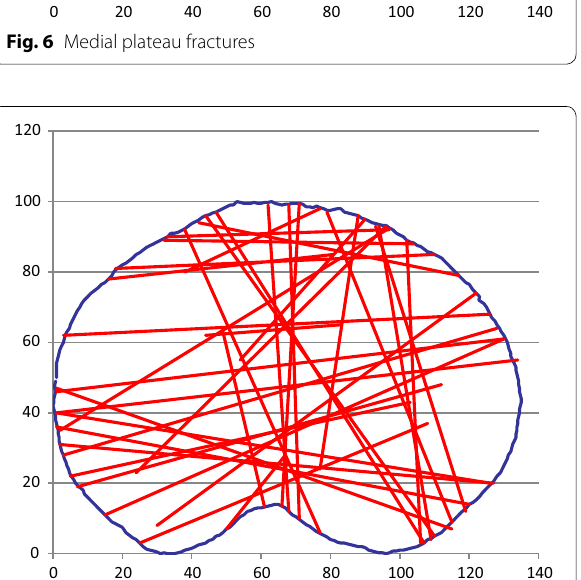
Fig. 5 Lateral plateau fractures